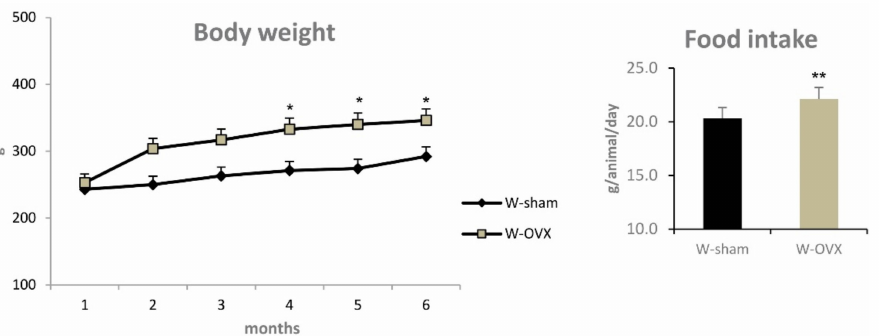
Figure 1. Whole body weight (over a 4-month experimental period) and food intake in ovariec- tomized Wistar female rats compared to sham-operated controls. Significance was determined using the unpaired Student’s t test (* denotes p < 0.05, ** denotes p < 0.01). Compared with sham-operated controls, ovariectomized female rats exhibited markedly increased body weight (+10%, p < 0.05) and visceral adipose tissue weight (+10%, p <